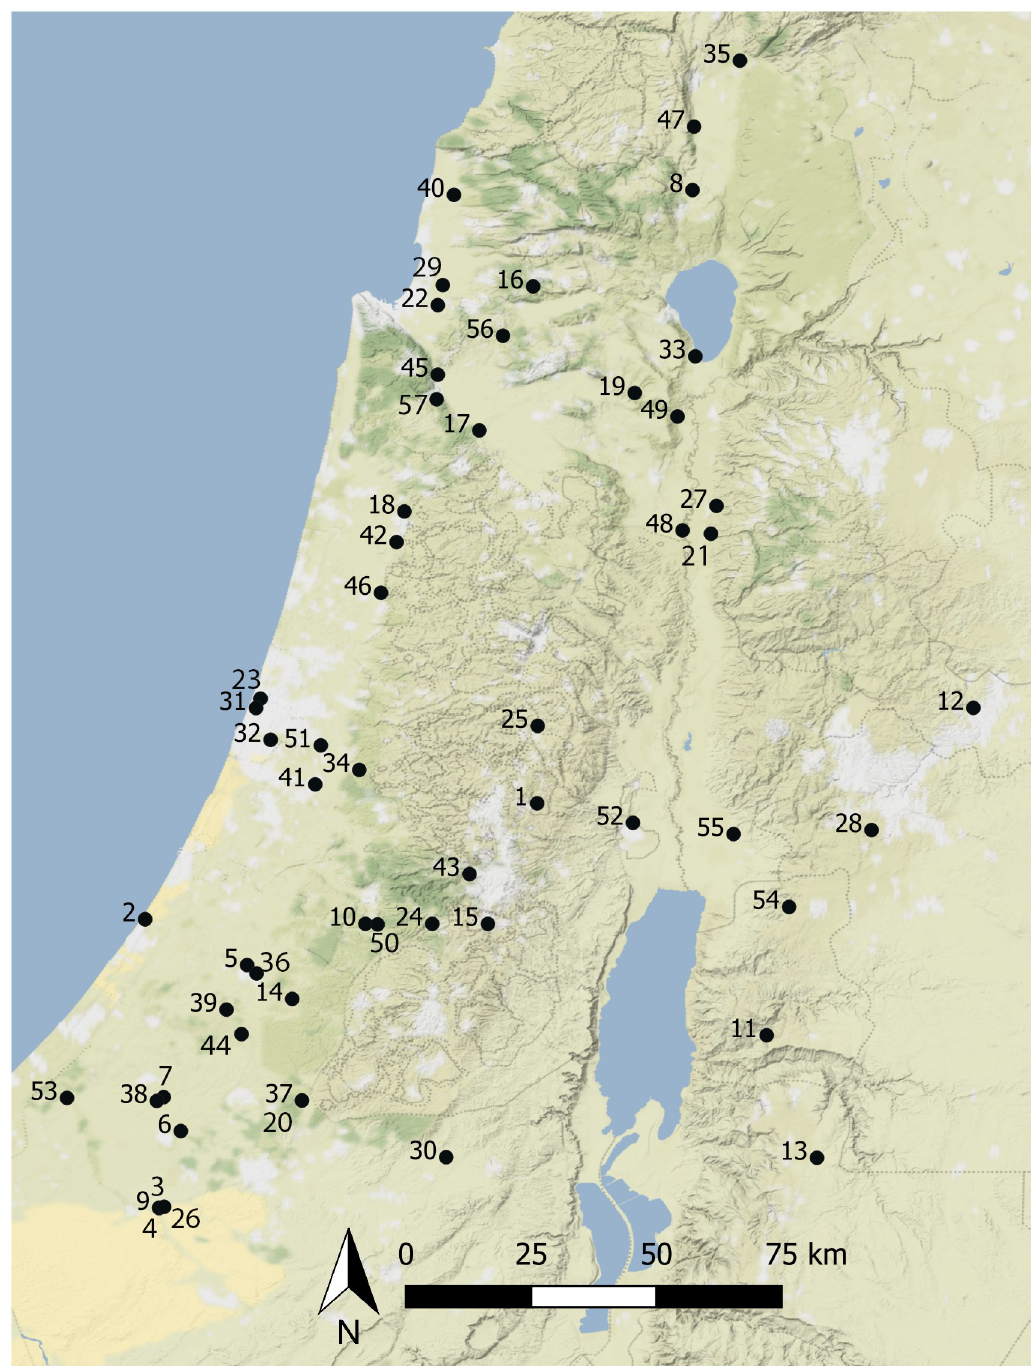
Fig 1. Location of the sites used in this study. Further details on these sites are available in Table 2. Basemap: Stamen Terrain (obtained through QuickMapServices QGIS plugin), (cc) OpenStreetMap contributors.